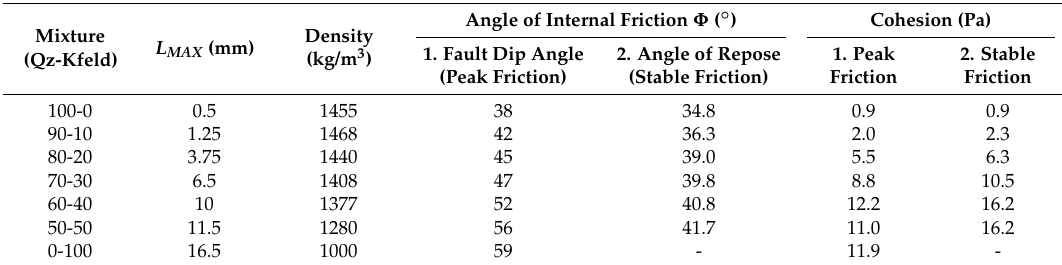
Table 6. Cohesion of the different mixtures measured with the maximum vertical wall methods (see text for details). The two different values (1 and 2) arise from the different angles of internal friction used in the calculation (Equations (3) and (4)).